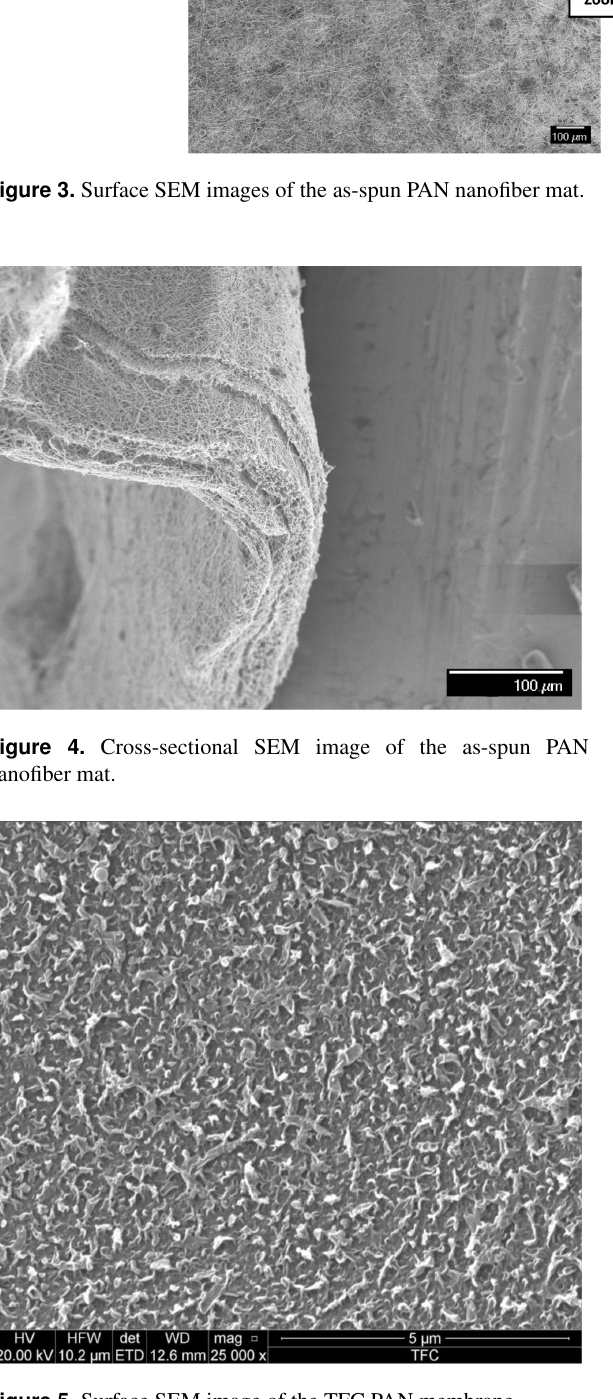
Figure 5. Surface SEM image of the TFC PAN